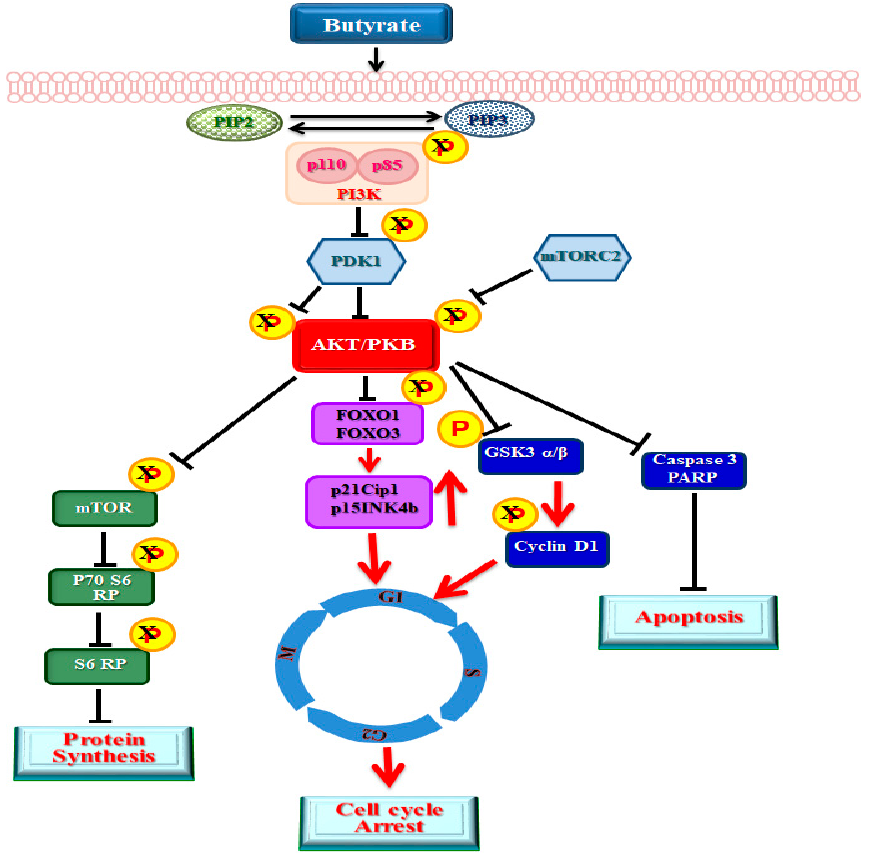
Figure 9. Butyrate-inhibited Akt activation arrests VSMC proliferation promoting VSMC growth via its downstream targets. Increased expression of cyclin D1, and its stability due to inhibition of GSK3 activity along with increased expression of p21Cip1 / Waf1 and p15INK4B through the activation of FOXO proteins by butyrate arrests VSMCs in G1-phase (red arrows). Additionally, inhibition of caspase 3 activity and downregulation of PARP by butyrate inhibits apoptosis. Inhibition of mTOR-mediated protein synthesis appears to have no e ff ect on VSMC